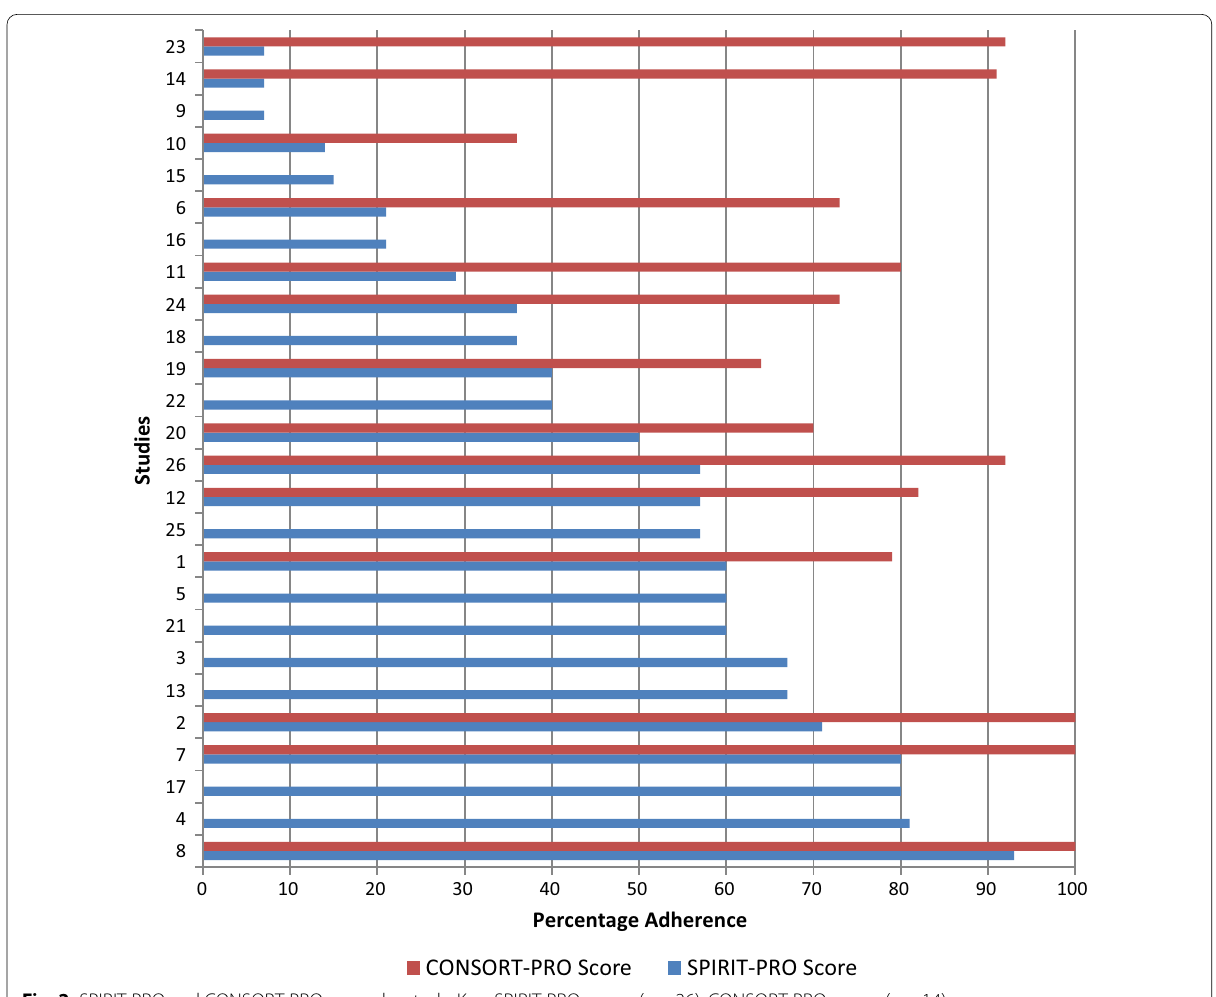
Fig. 2 SPIRIT-PRO and CONSORT-PRO scores by study. Key: SPIRIT-PRO scores (n